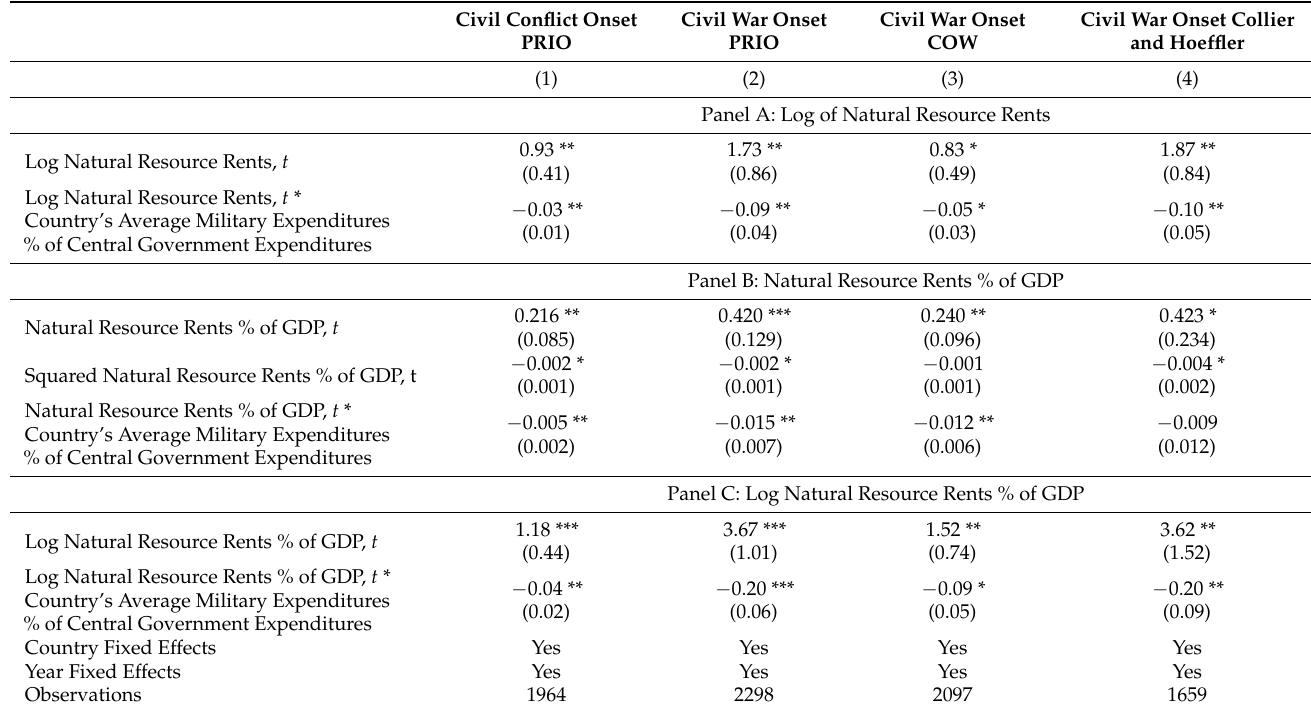
Table 1. Natural Resource Rents and the Risk of Civil Conflict Onset: The Role of Military